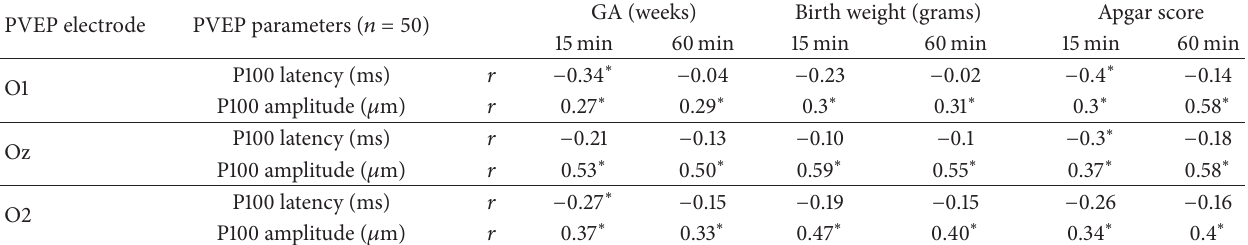
Table 2: Correlation of PVEP variables with gestational age (weeks), birth weight (grams), and Apgar score. PVEP electrode